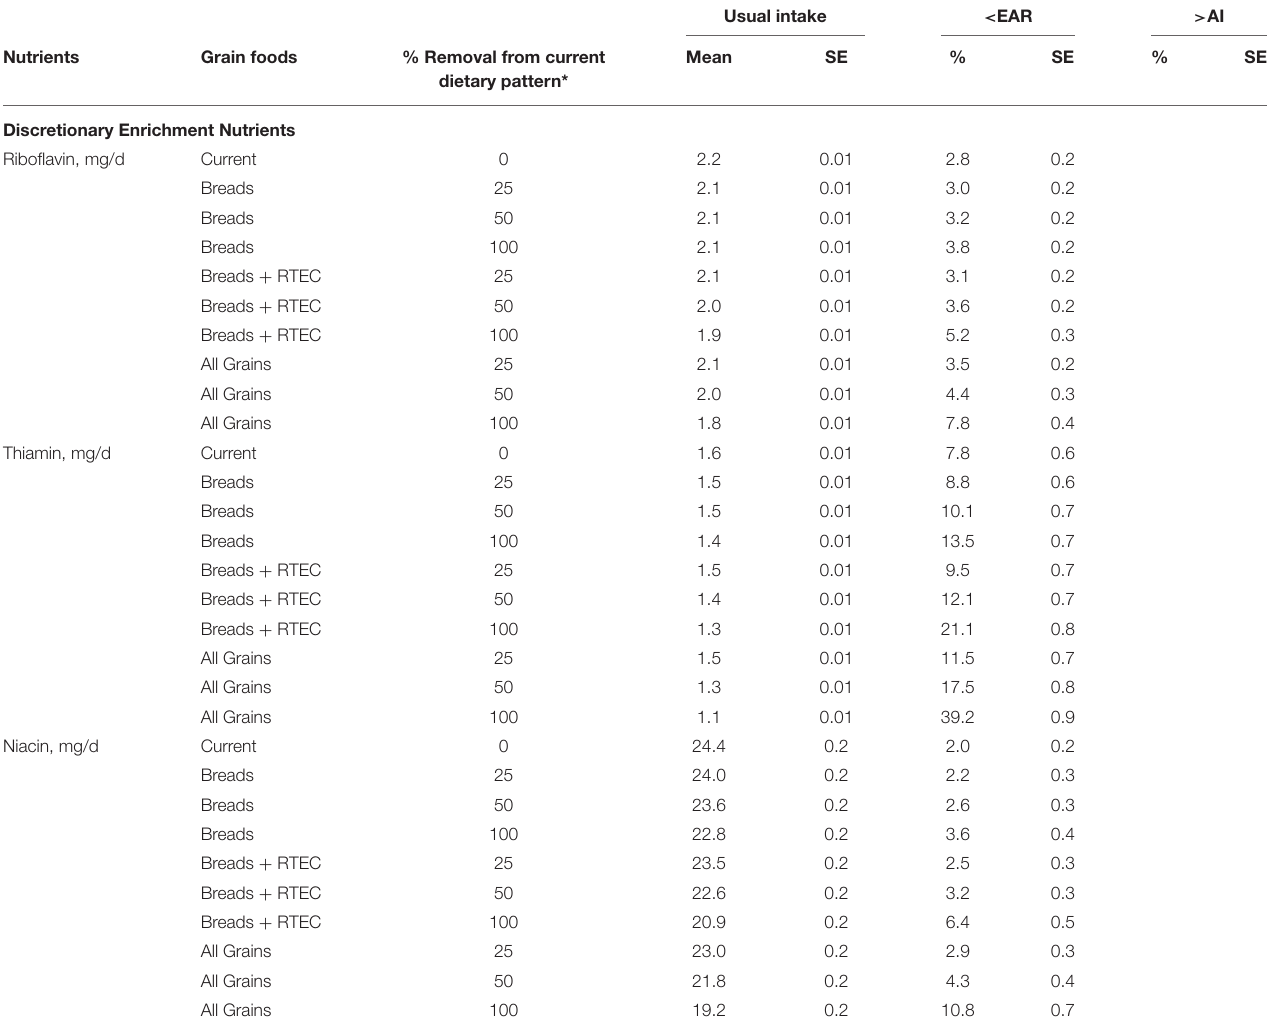
TABLE 7 | Discretionary enrichment nutrients: mean usual nutrient intakes, usual intake percentiles, and DRI, and percentages meeting recommendations in 51–99-year-old adults.